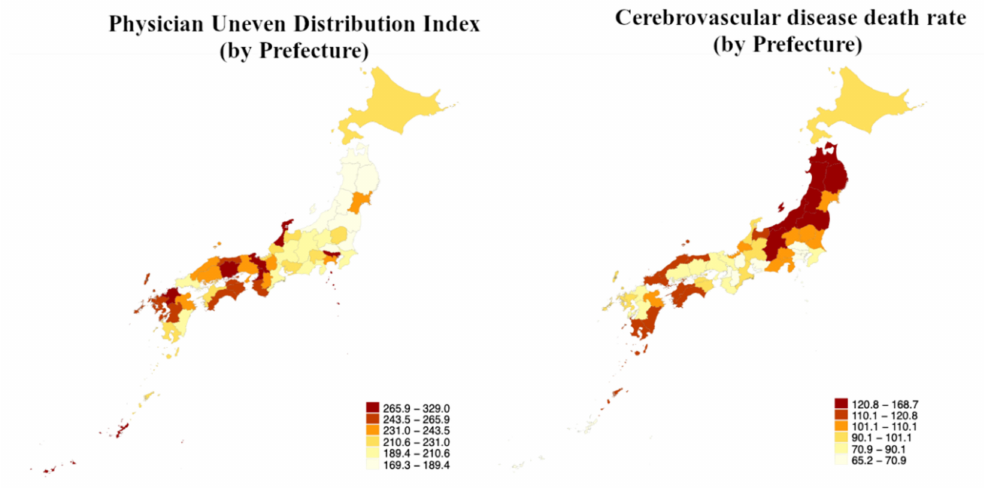
Figure 1. Geographical distribution of Physician Uneven Distribution Index (PUDI) and Cere- brovascular disease (CeVD) death rate in Japan. Northern Honshu has low PUDI and high CeVD death